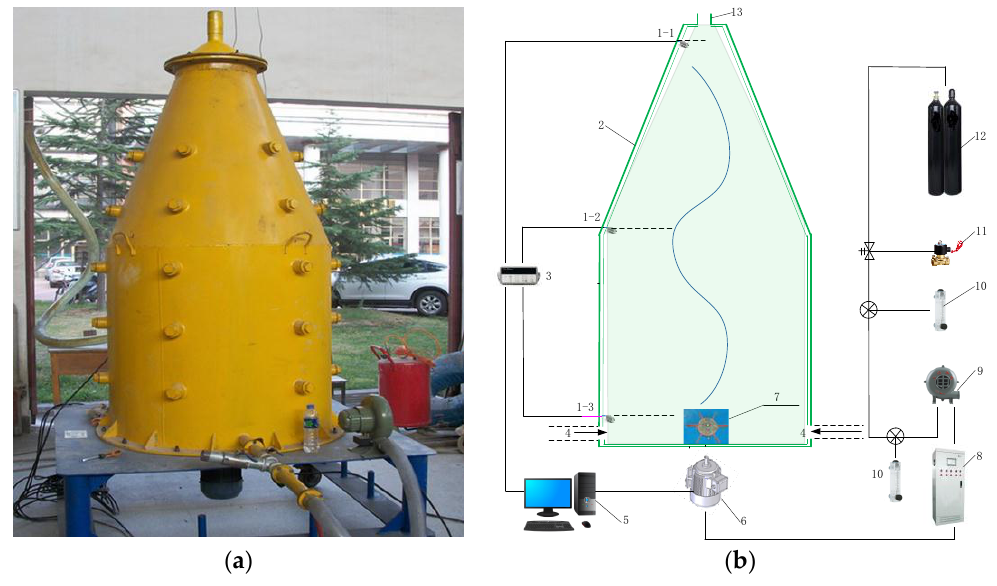
Figure 1. Schematic diagram of methane enrichment tower system. ( a ) The physical map of the enrichment tower system; ( b ) the sketch of the enrichment tower system. 1 (1-1, 1-2, 1-3)—methane sensor, 2—tower equipment, 3—data collection system, 4—air inlet, 5—computer, 6—explosion-proof motors by a frequency conversion function, 7—blades, 8—electric control box, 9—fan 10—flowmeter, 11—control valve, 12—methane cylinders, 13—air outlet.